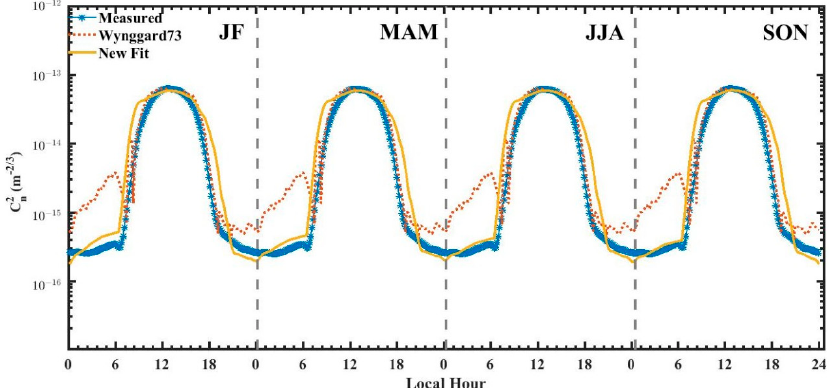
Figure 6. Comparison of diurnal variation between measured and model-estimated log (cid:2869)(cid:2868) ( 𝐶 (cid:3041)(cid:2870) )